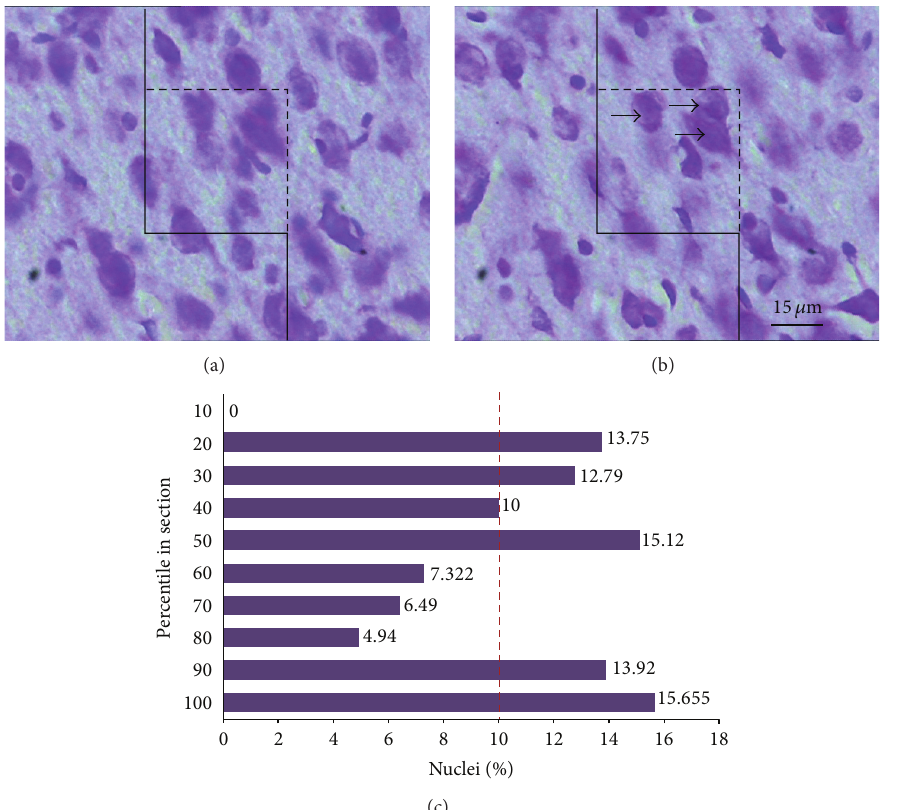
Figure 1: Optical disector method. (a) Look-up section of the disector. (b) Reference section. The cells whose nucleoli appeared in the reference section and did not touch the left and lower borders of the frame were counted. (c) The plot of the 𝑧 -axis distribution of the nuclei. Each histogram indicates the percentile of the counted nuclei in ten percent of the section